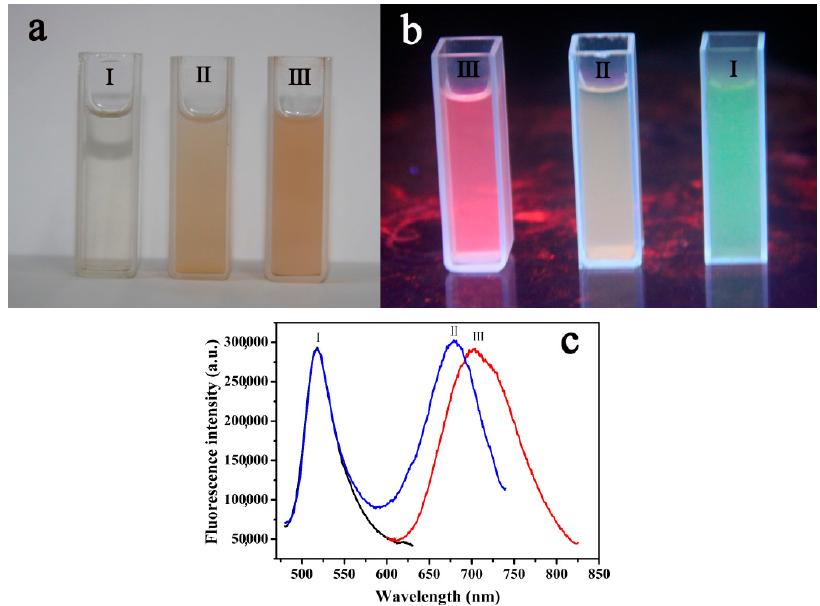
Figure 1. Photographs of the FITC–SiO 2 (I), RFN (II), and AuNCs (III) in the sunlight ( a ) and under the ultraviolet lamp ( b ). The FL spectra of FITC–SiO 2 (I), RFN (II), and AuNCs (III) ( c ).